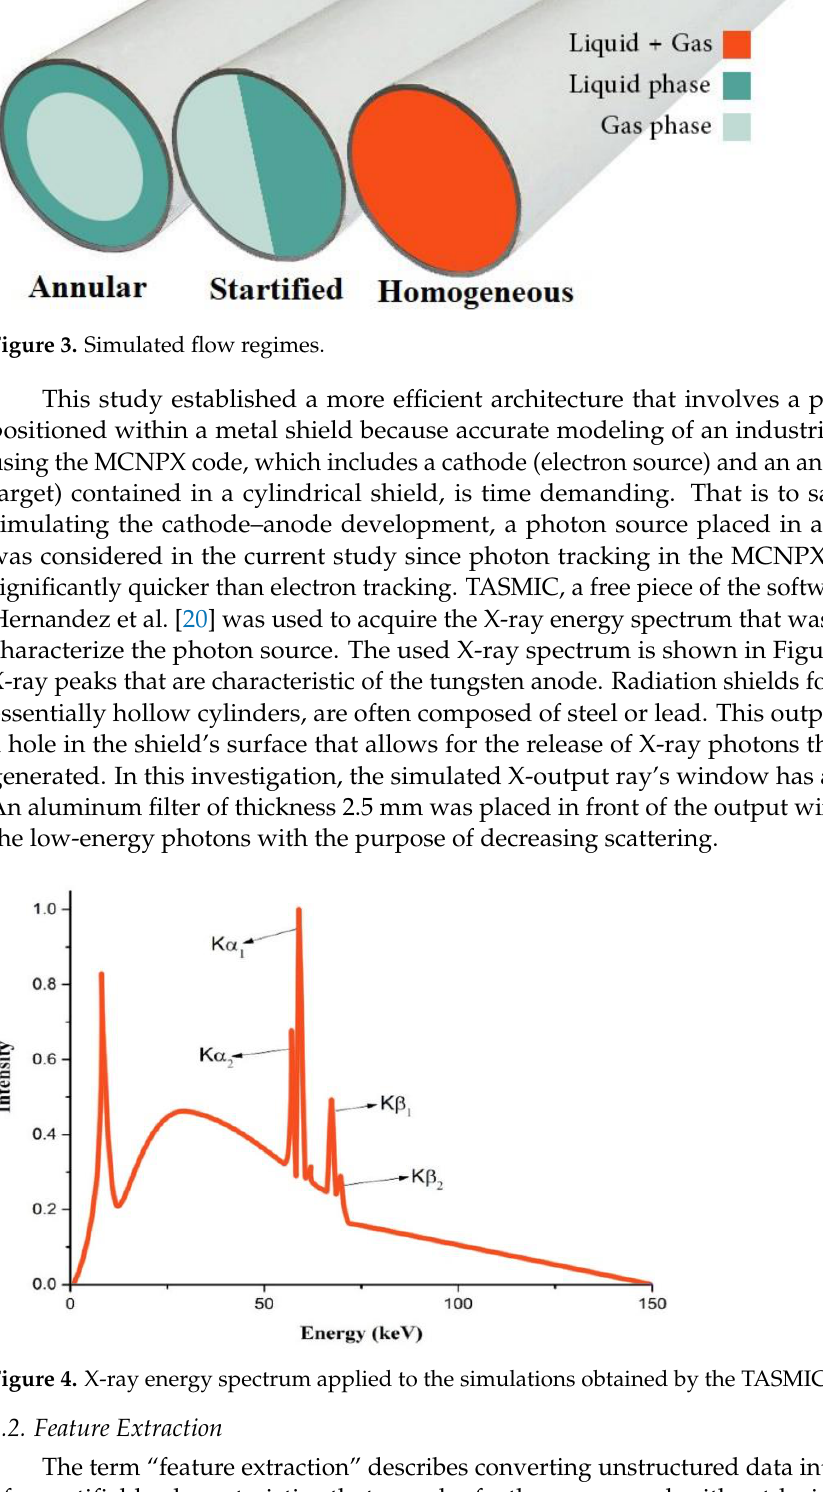
Figure 2. Proposed detection system structure.